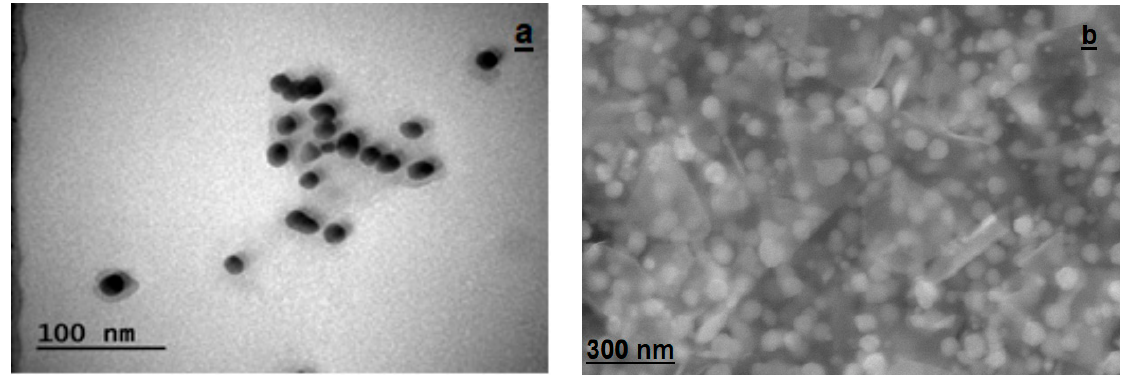
1.1216 Figure 5. Elemental profile (EDX) of gold nanoparticle synthesis with Amygdalus communis leaf ex- tract. 2.2.5. Morphological Structures of Synthesized AC-AuNPs TEM (transmission electron microscopy) and FESEM (field-emission scanning elec- tron microscopy) techniques were used to determine the size, morphology, and dispersion of the biogenic gold nanoparticles. Figure 6a shows a TEM micrograph of the biogenic